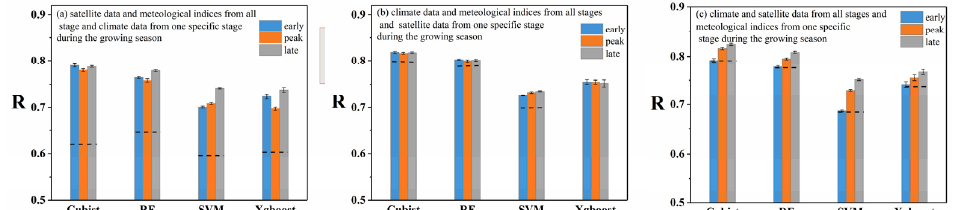
Figure 5. ( a ) The R values using satellite data and meteorological indices for all stages but using climate data for only one stage of the maize growing season, which was divided into early (Mar and Apr), peak (May and Jun), and late (Jul and Aug) stages. ( b ) R values using climate data and meteorological indices for all stages but using satellite data for only one stage. ( c ) R values using climate and satellite data for all stages but using meteorological indices for only one stage. The dashed lines in ( a – c ) represent the benchmark model performance when using satellite data only, climate data only, and meteorological indices only during all stages, respectively.